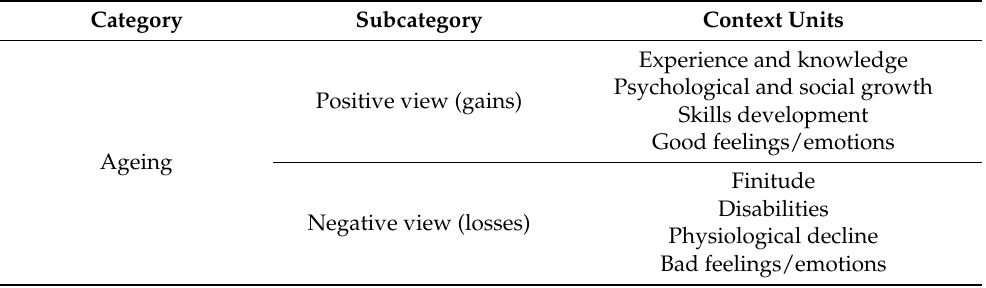
Table 5. Category, subcategory, and context units of qualitative